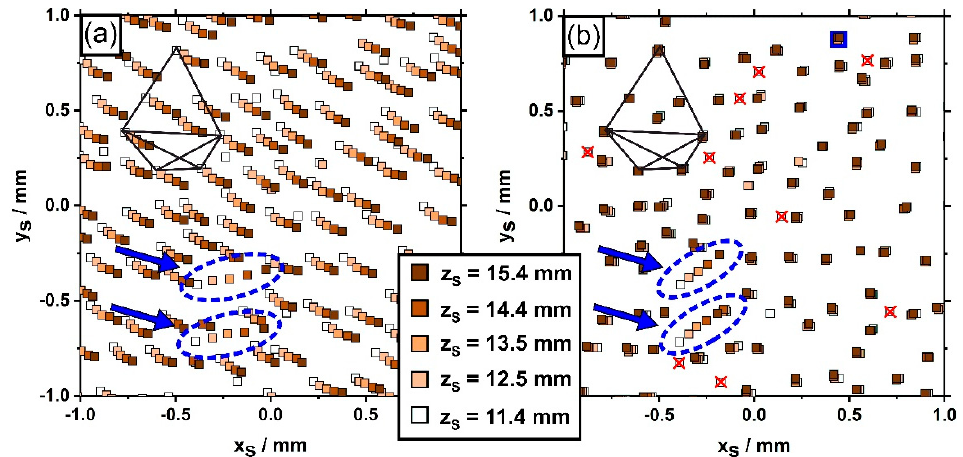
Figure 8. Color-coded microstructural data that show the evolution of dendrite core positions during 4 mm growth (from z S = 11.4 mm to z S = 15.4 mm) ( a ) Raw data. ( b ) Same microstructural data as presented in ( a ) after alignment. The black polygonal reference group represents the same dendrites as in Figure 5a. The blue arrows highlight two dendrites which do not follow the average growth trend. Small red crosses in ( b ) indicate dendrites that were no longer detected after z S = 11.4 mm. The blue square in the upper right is related to one dendrite which newly formed during the first 1.1 mm growth.